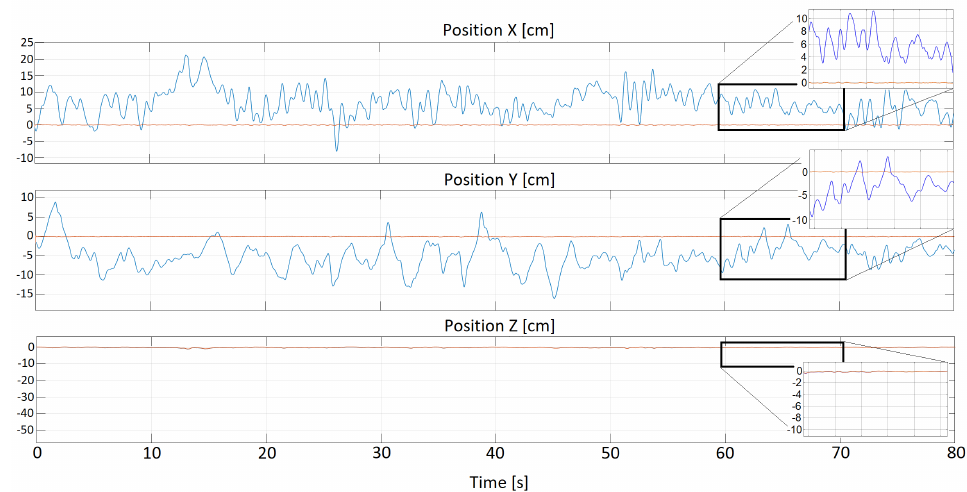
Figure 11. Stabilization studies—the optimization method; blue line: disturbances, red line: con- trolled signal, speed: 10 km/h [Source: MovieBird